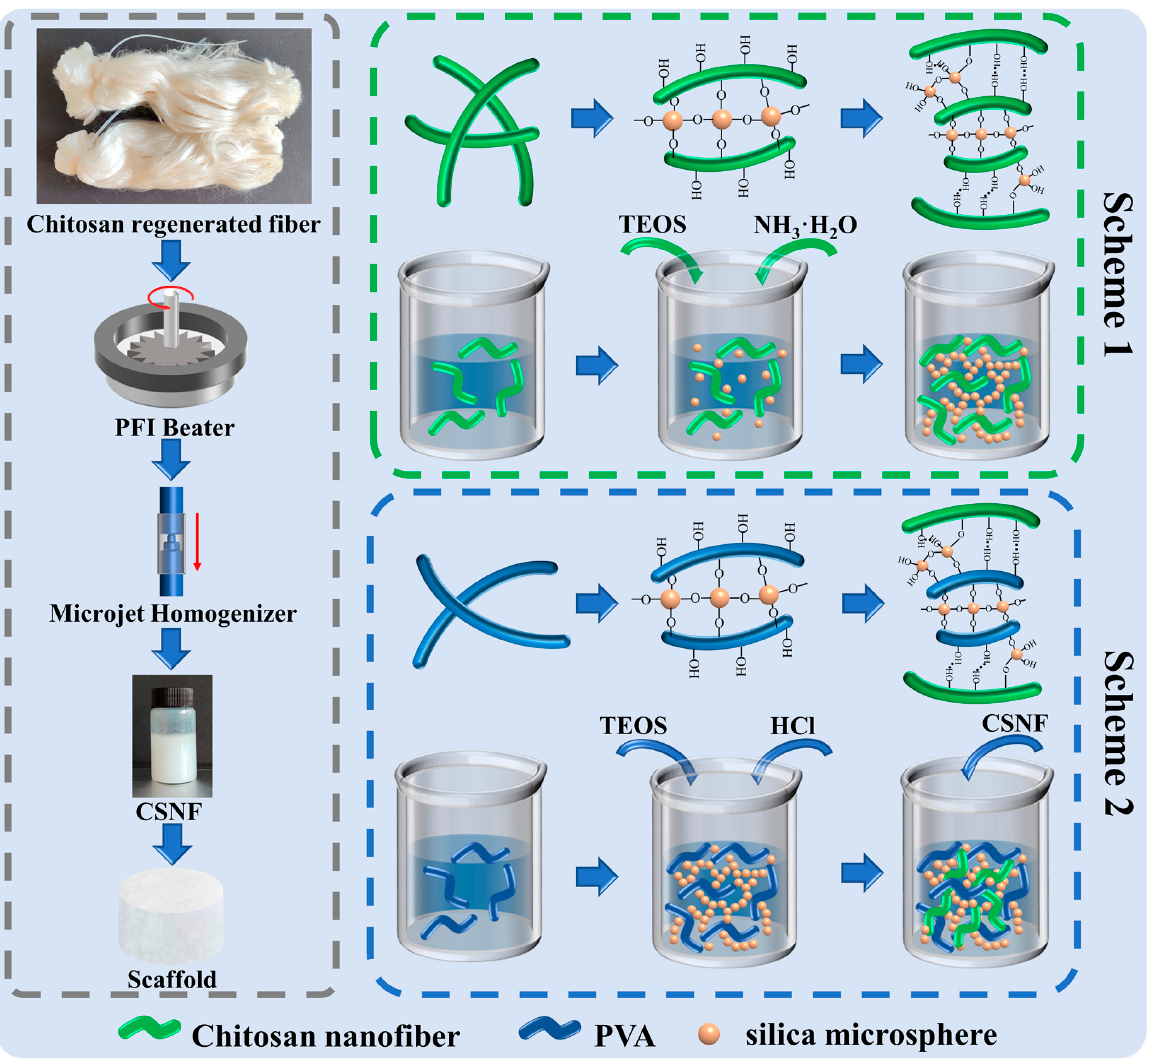
Figure 1. Schematic drawing of chitosan nanofiber/nanoSiO 2 ( Scheme 1 ), and chitosan nanofiber/na ‐ Schematic drawing of chitosan nanofiber/nanoSiO 2 ( Scheme 1 ), and chitosan noSiO 2 /PVA ( Scheme 2 ) scaffolds preparation steps. nanofiber/nanoSiO 2 /PVA ( Scheme 2 ) scaffolds preparation